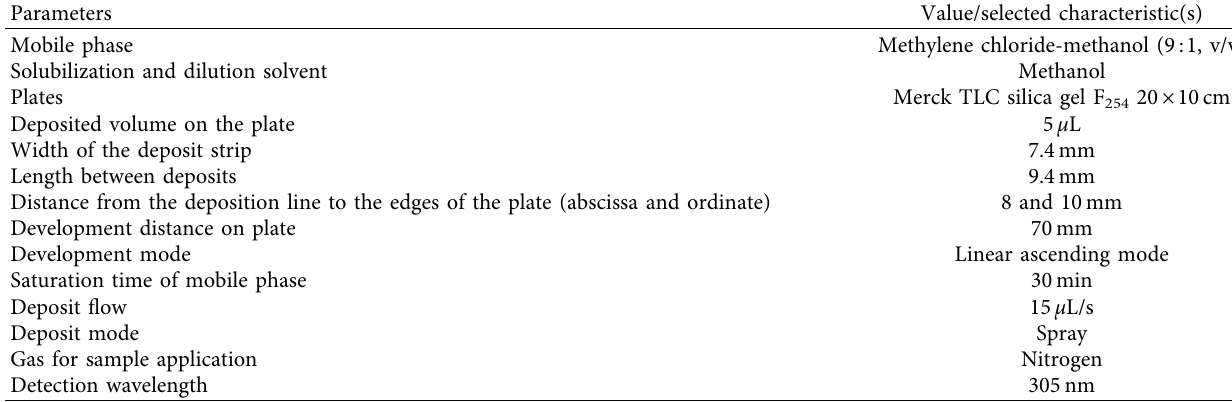
Table 2: Optimized operating conditions for the determination of